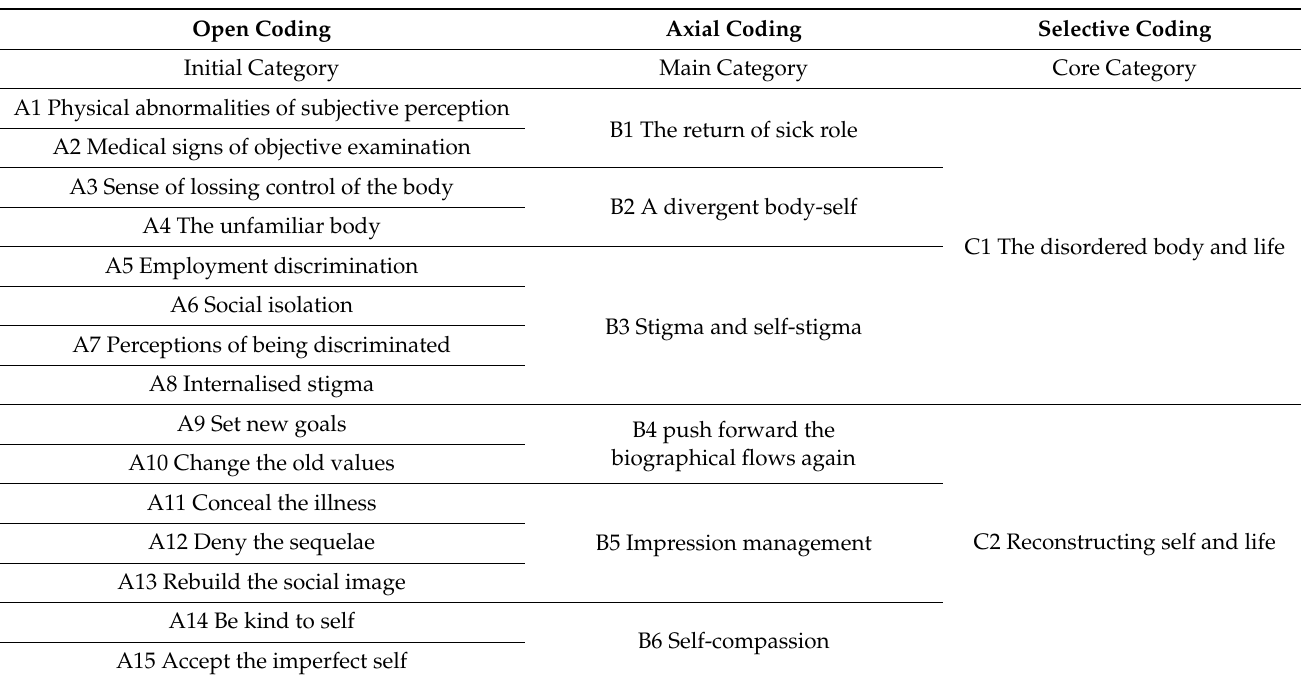
Table 2. The Three-level Coding